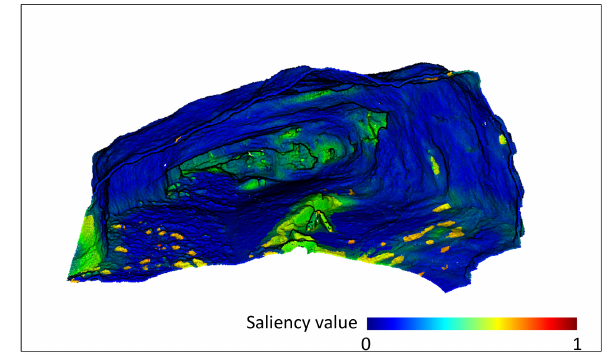
Figure 4. Estimated saliency in the cave dataset. The entire cave is analysed at